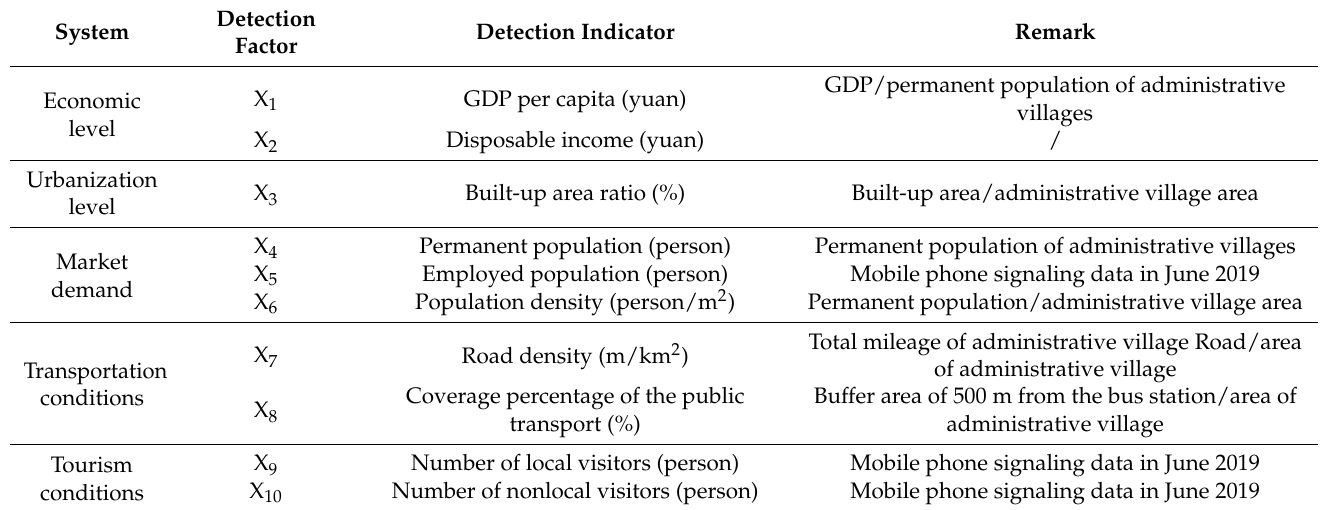
Table 4. The detection indicator system for influencing